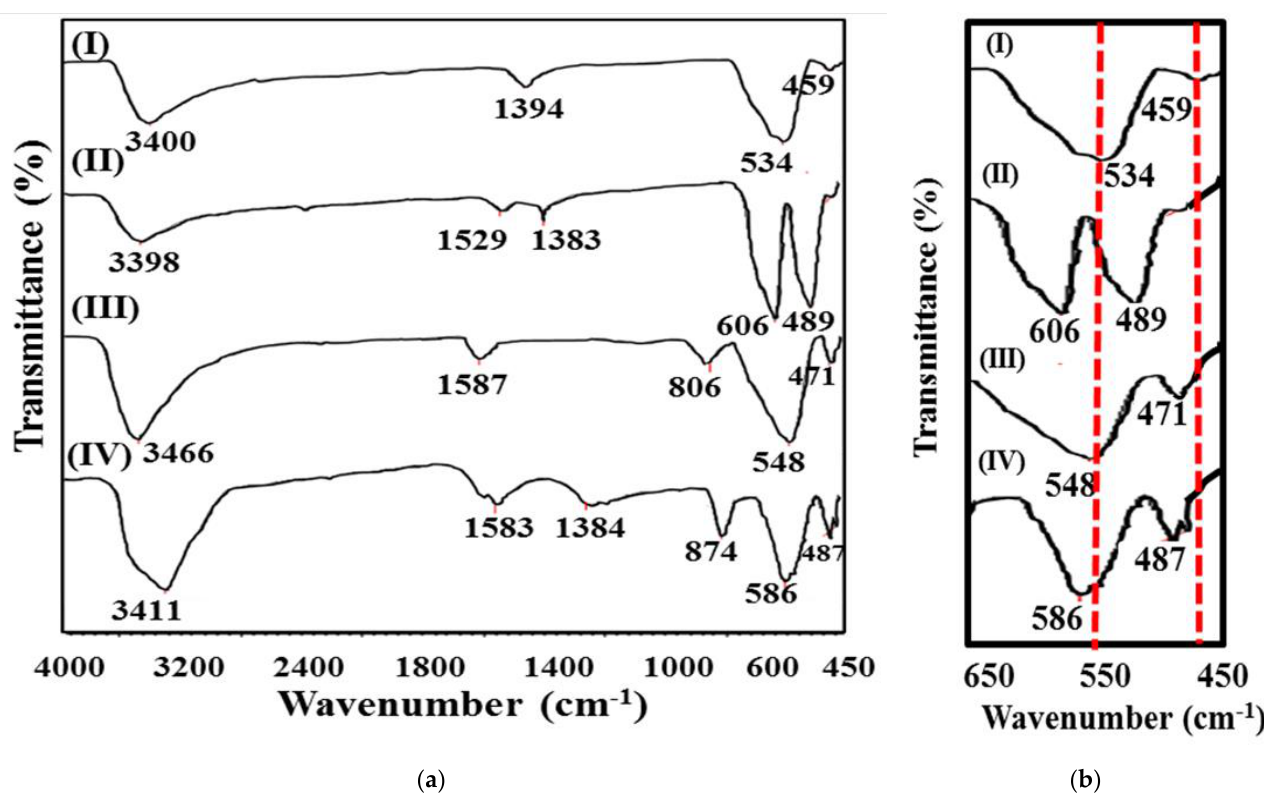
Figure 2. ( a ) FT-IR spectra of (I) SrFe 2 O 4 , (II) TiFe 2 O 5 , (III) Sr 0.7 Ti 0.3 Fe 2 O 4.3 and (IV) Sr 0.4 Ti 0.6 Fe 2 O 4.6 and ( b ) enlarged view of the peak shift position of metal – oxygen FT-IR peaks (Dotted red line represents the location of metal – oxygen tetrahedral and octahedral stretching peaks for SrFe 2 O 4 NPs)